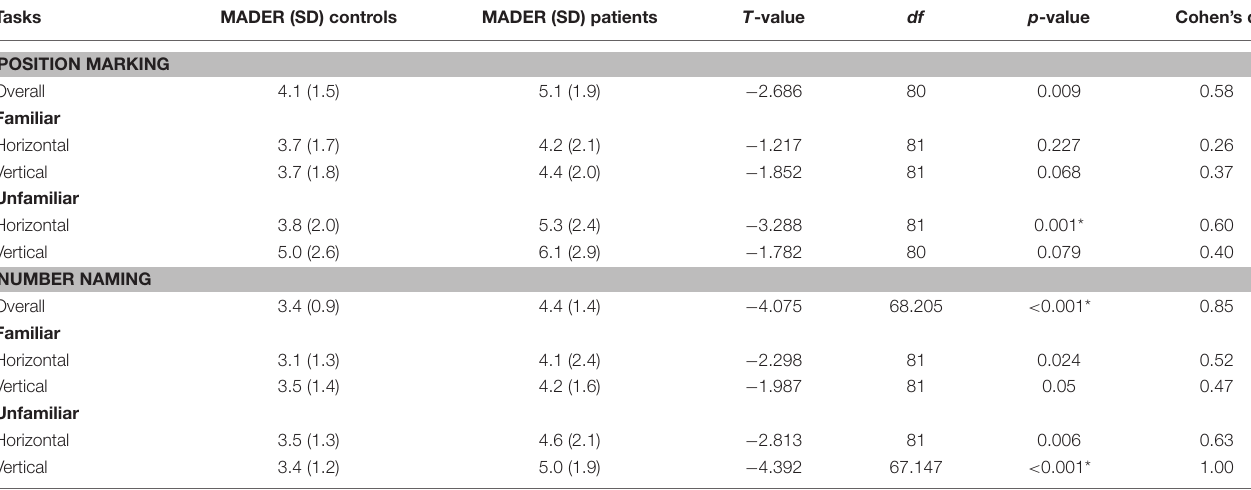
TABLE 2 | Comparisons of MADER for different experimental conditions using independent samples